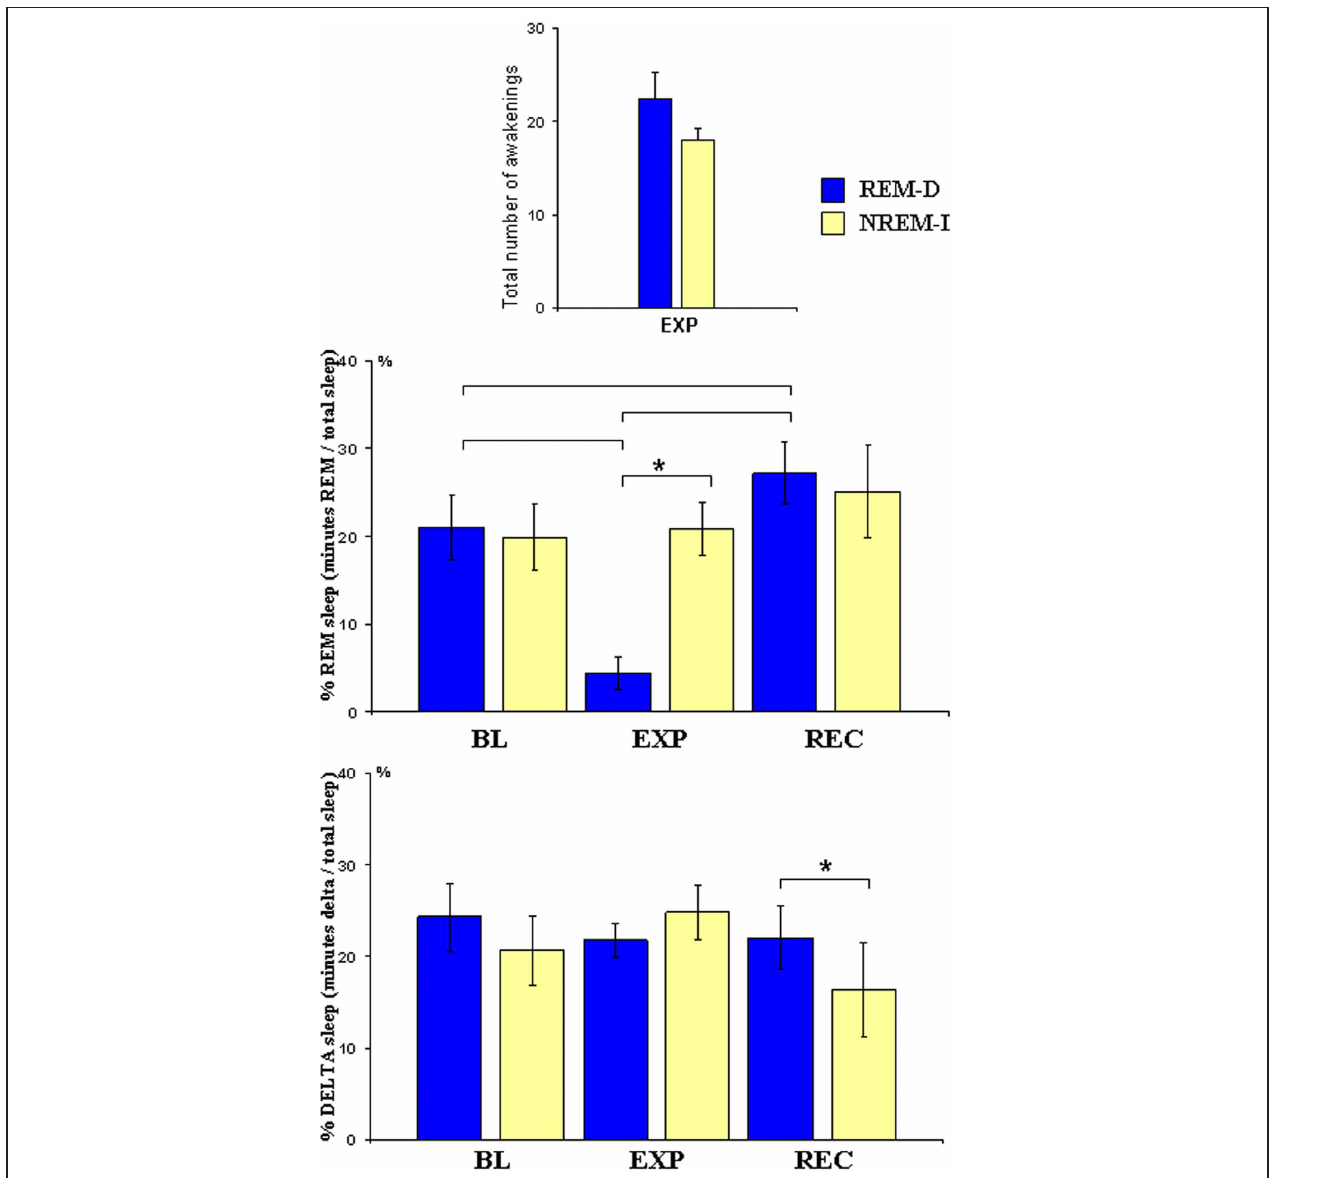
recovery (REC) nights for the REM sleep deprivation (REM-D), and non-REM sleep interruptions (NREM-I) groups; Brackets indicate significant post-hoc differences in the REM-D group whereas asterisk above bracket represents differences between